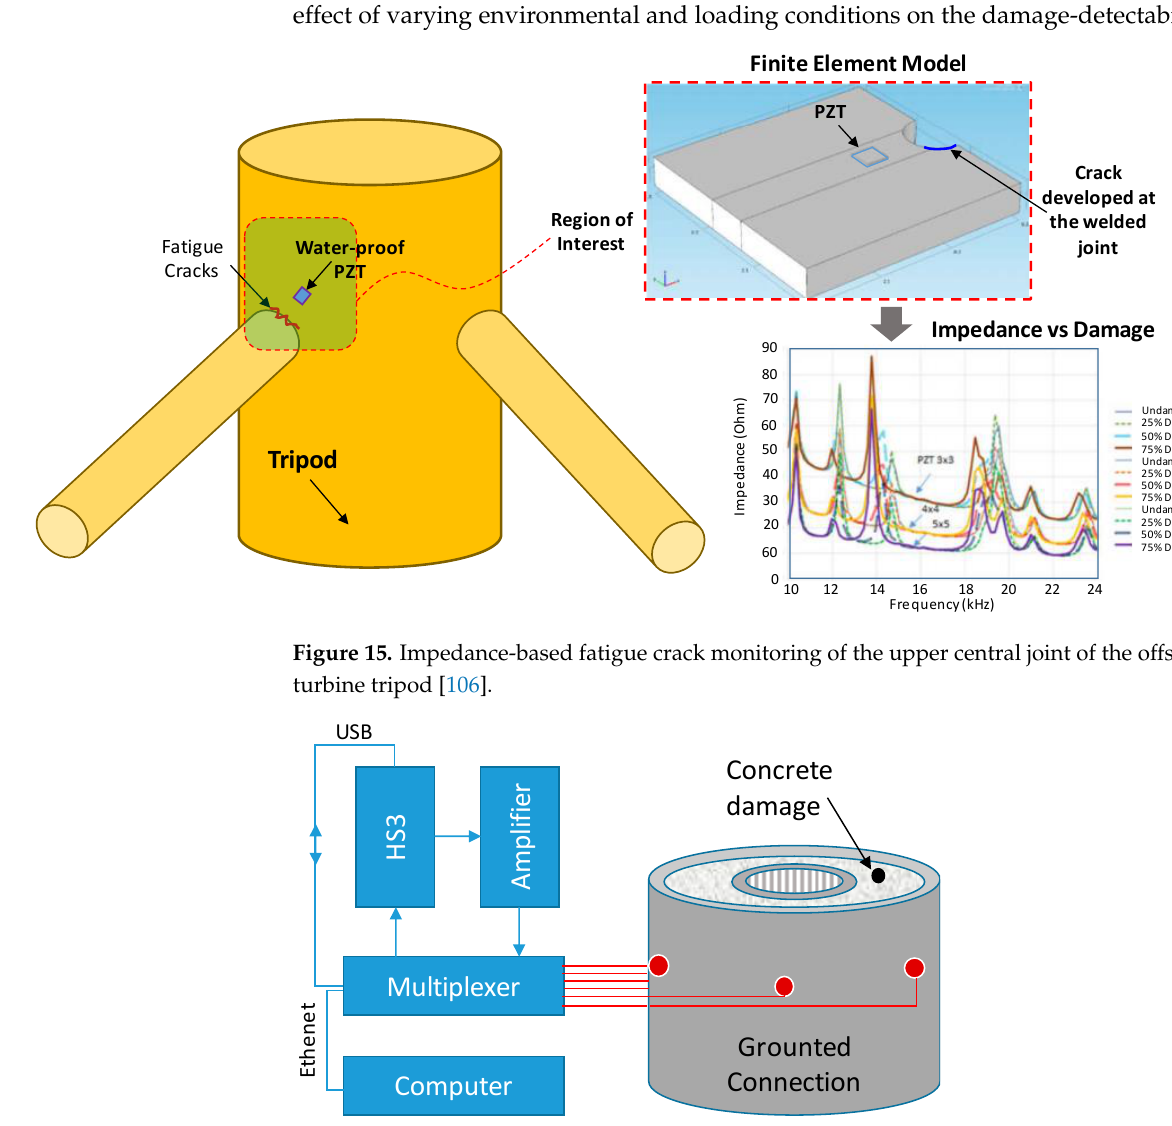
Figure 16. Experimental setup of impedance-based SHM of a grouted connection